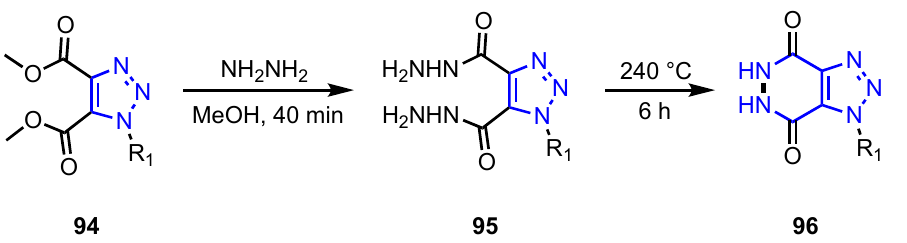
Scheme 25. Intramolecular cyclization of diacylhydrazide 95 , forming 1,2,3-triazolo[4,5- d ]pyridazine 96 upon high heat with loss of hydrazine. (R 1 = alkyl.)